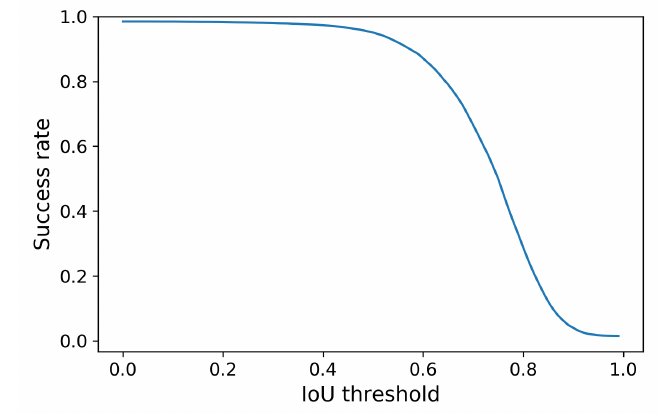
Figure 4. Success plot for the combination of Tiny YOLOv3 (You Only Look Once, version 3) +